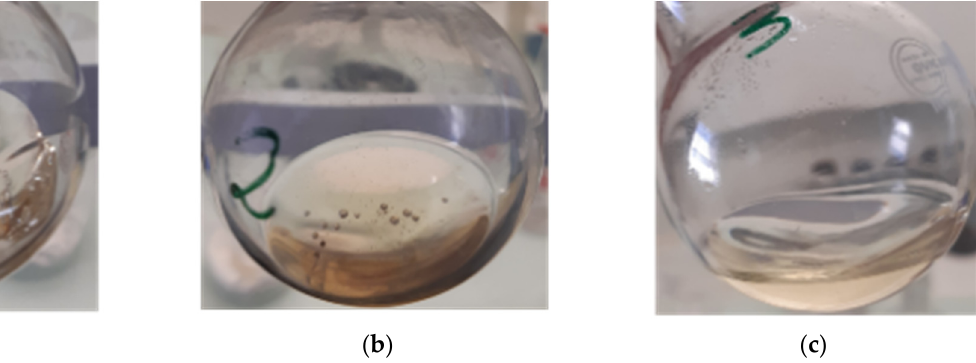
Figure 7. Dissolution of Elium ® resin during 24 h with acetone at different “resin:solvent” ratios: ( a )